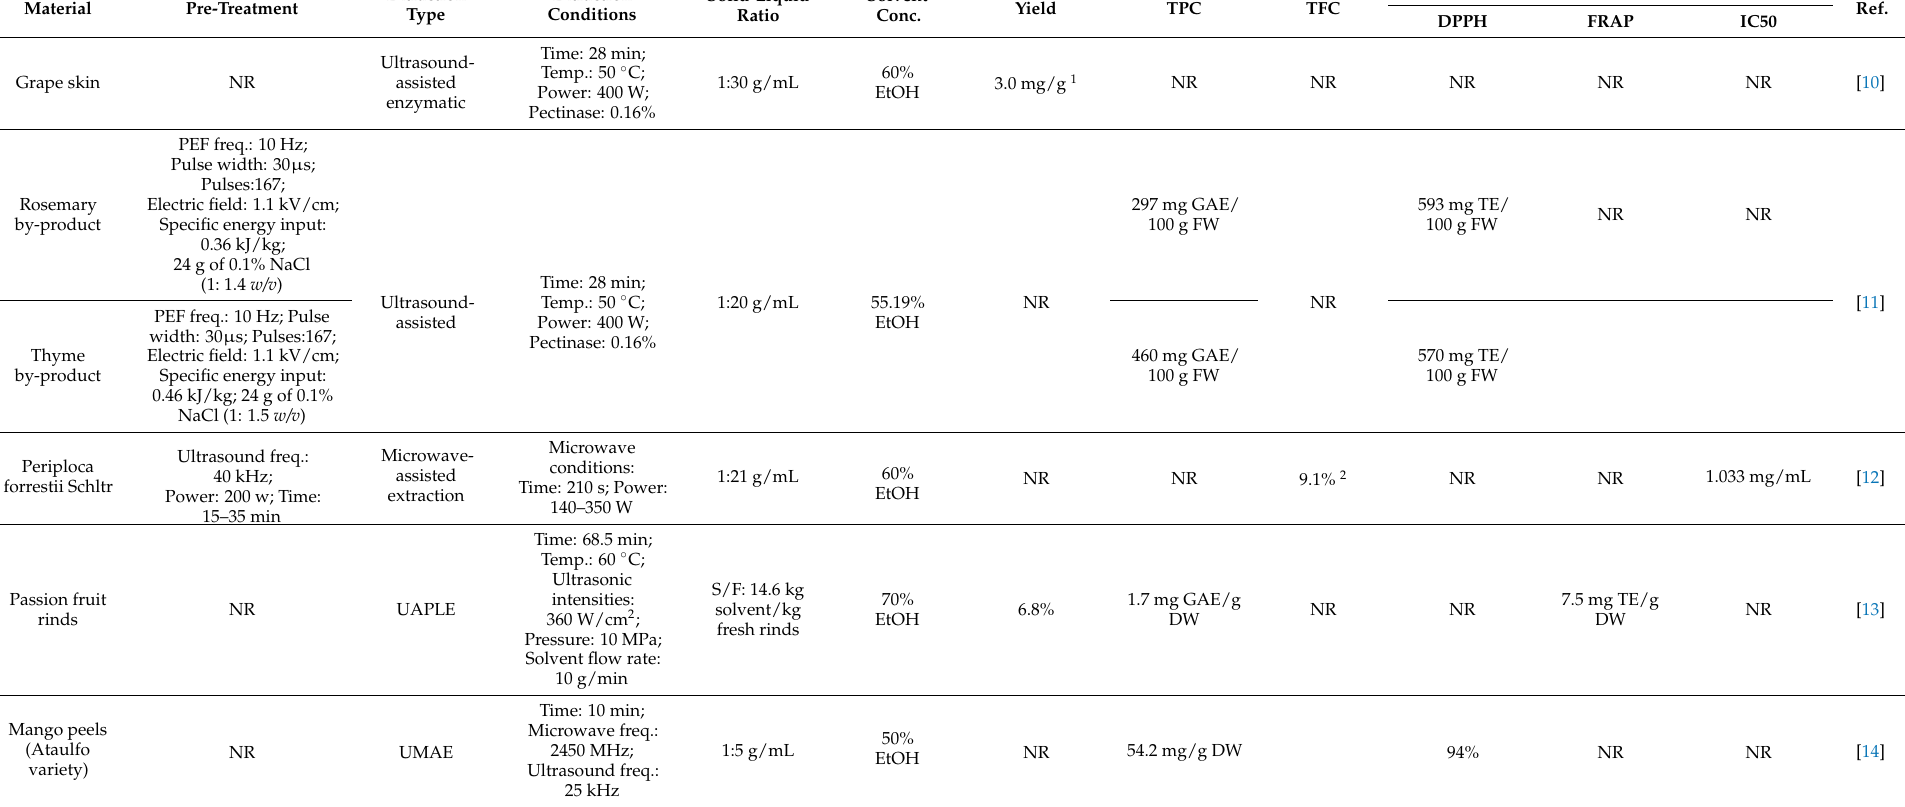
Table 1. Combination of ultrasound with other techniques for extraction of bioactive